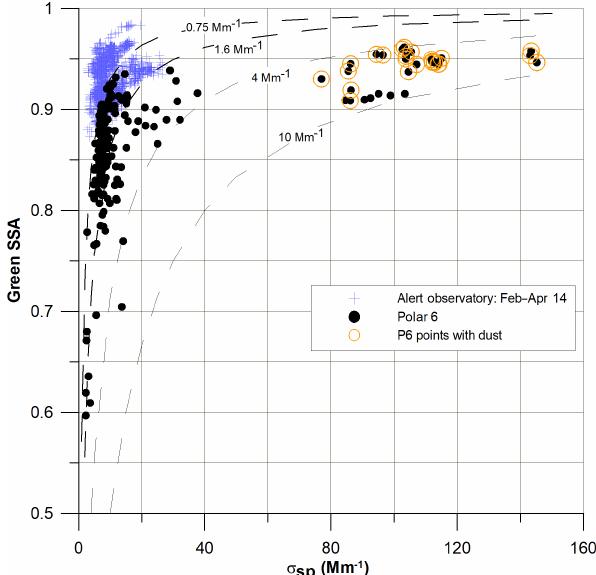
Figure 4. Single scattering albedo (SSA) at the green wavelength (550nm) plotted against the particle light scattering coefficient ( σ sp ) at 550nm. Data are separated between those collected at the Alert observatory (blue crosses) and those collected from the Po- lar 6 (P6) aircraft (black dots). In addition, points influenced most strongly by dust are circled in orange. Lines of equal particle light absorption ( σ ap ) are for reference.